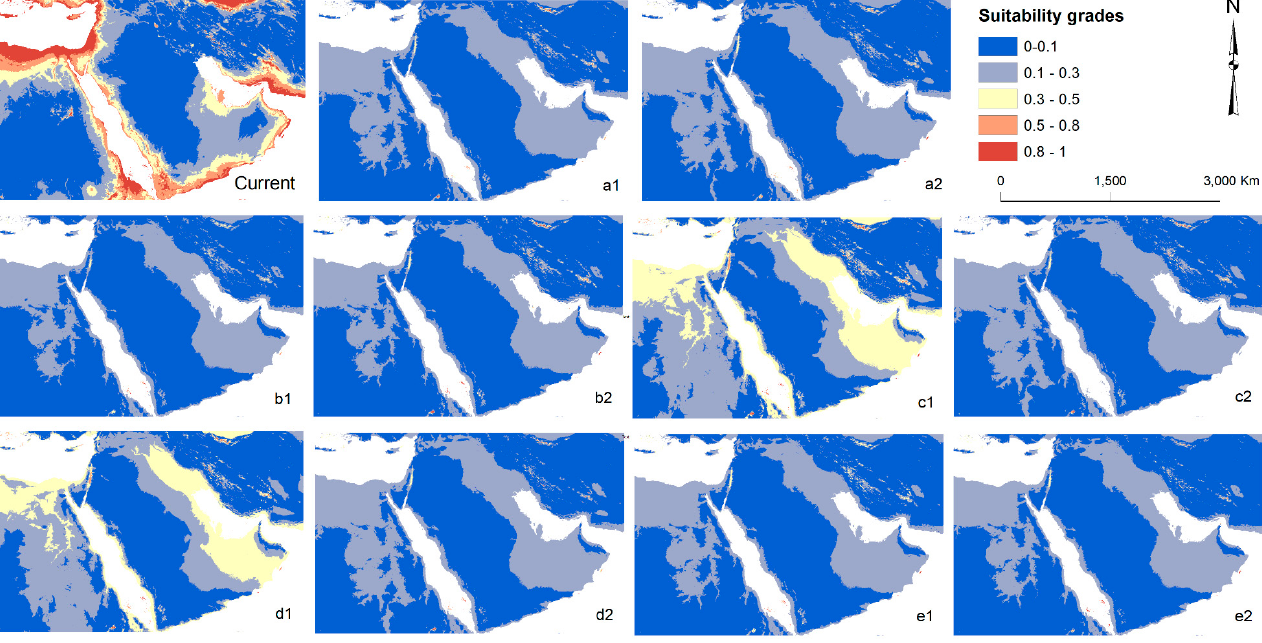
Figure 3. Predicted future habitat suitability of Spogostylum ocyale in Egypt and some Middle Eastern countries for the year 2085 (2071–2100) by five general circulation models (GCMs): a GFDL- ESM4, b IPSL-CM6A-LR, c MPI-ESM1-2-HR, d MRI-ESM2-0 and e UKESM1-0-LL (according to ssp126; SSP1-RCP2.6 emission scenario (1) and ssp585; SSP5-RCP8.5 emission scenario (2)).